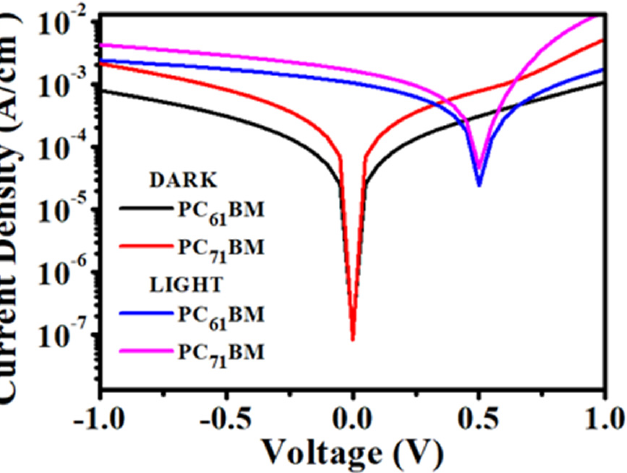
Figure 6. Current density–voltage (J–V) characteristics of PC 61 BM and PC 71 BM under dark and light illumination. Table 1. Performance of PC 61 BM and PC 71 BM as a photodiode.